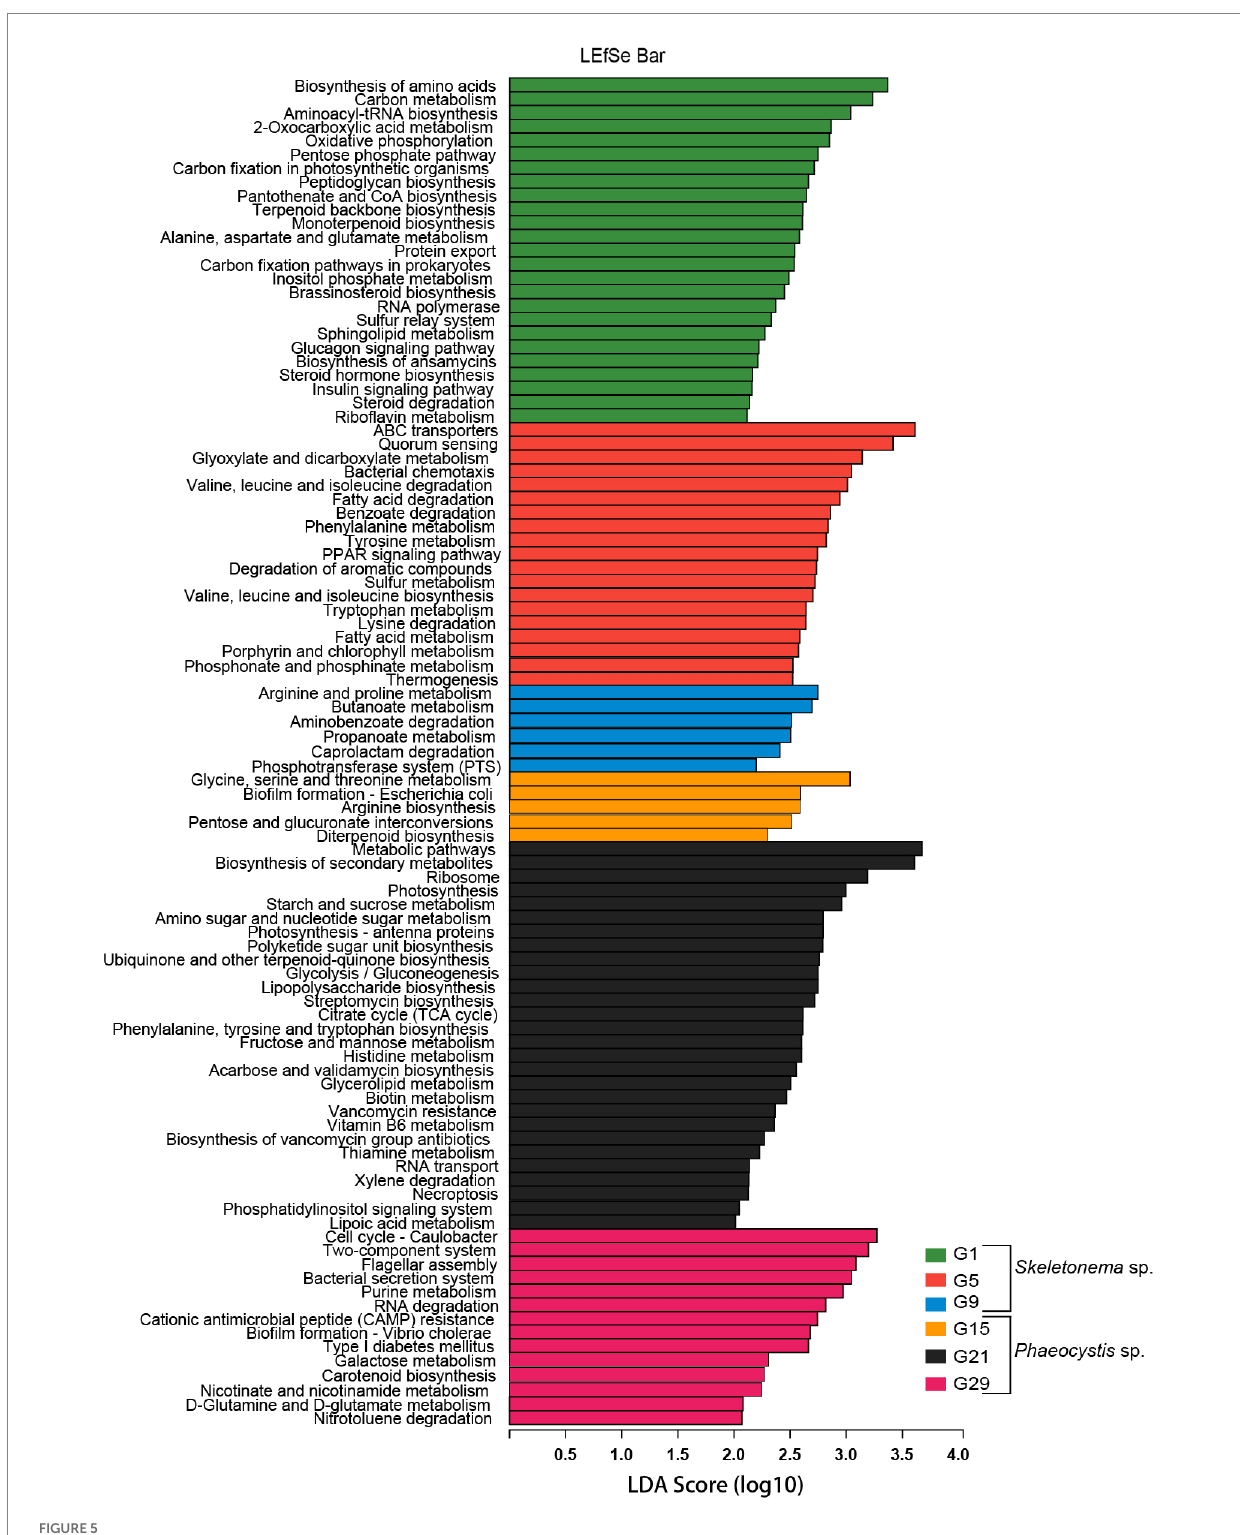
FIGURE 5 Predicted genes from metagenome related to KEGG pathways differentially represented between the bloom samples identified by LEfSe (LDA > 2, p < 0.05). Different metagenome sampling timepoints were distinguished by different colors. The horizontal bar on the right side indicates that the corresponding KEGG pathway (left side) was significantly enriched at that sampling